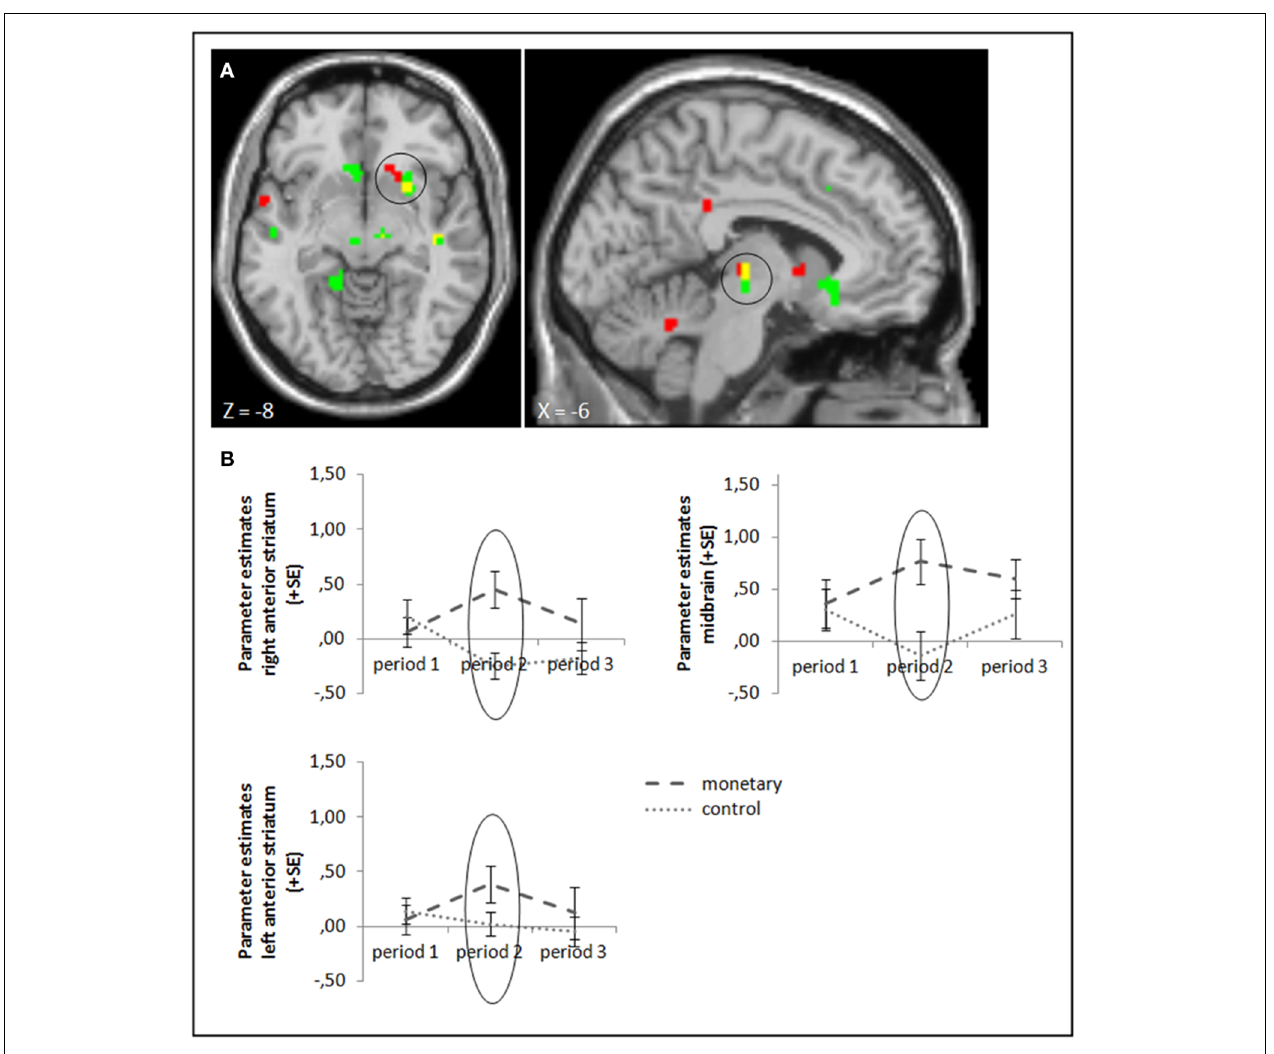
FIGURE 3 | (A) Activation for success—failure feedback was significantly higher in the right anterior striatum (left panel) and midbrain (right panel) in the monetary reward group compared to the control group in period 2 (whole brain uncorrected, p < 0 . 001, only clusters with a minimum of 10 activated